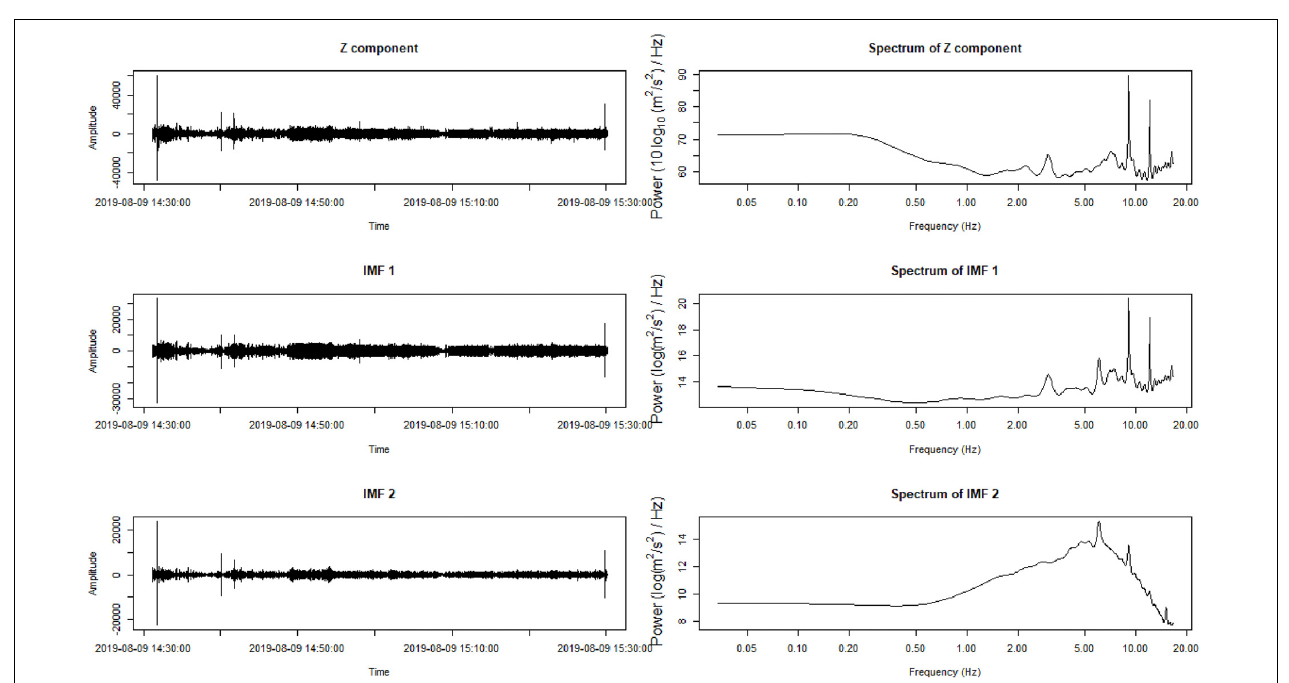
FIGURE 7 | Vertical components, IMF 1, and IMF 2 trace at Station MM099 (left) with its corresponding frequency spectrum (right) .